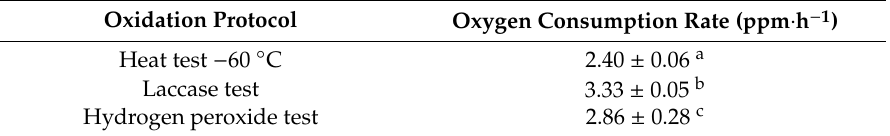
Table 1. Dissolved oxygen consumption rates in three di ff erent accelerated ageing tests. Rates are expressed as mean values ± standard error. Di ff erent letters indicate a significant di ff erence (Tukey test, α = 0.05) between oxidation protocols.